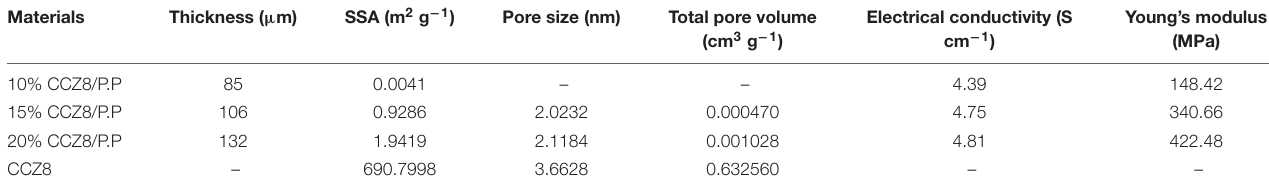
FIGURE 3 | Properties and chemical analysis of electrode films (A) Stress-strain curves of electrode films. (B) XRD patterns of electrode films. (C) I-V curves of electrode films. (D) Raman spectra of electrode films. (E) N 2 adsorption/desorption isotherms and pore size distribution (inset) of 20% CCZ8/P.P electrode films. (F) N 2 adsorption/desorption isotherms and pore size distribution (inset) of CCZ8 powder. TABLE 1 | Specific surface areas, pore size, total pore volumes, electrical conductivity and Young’s modulus of materials used in